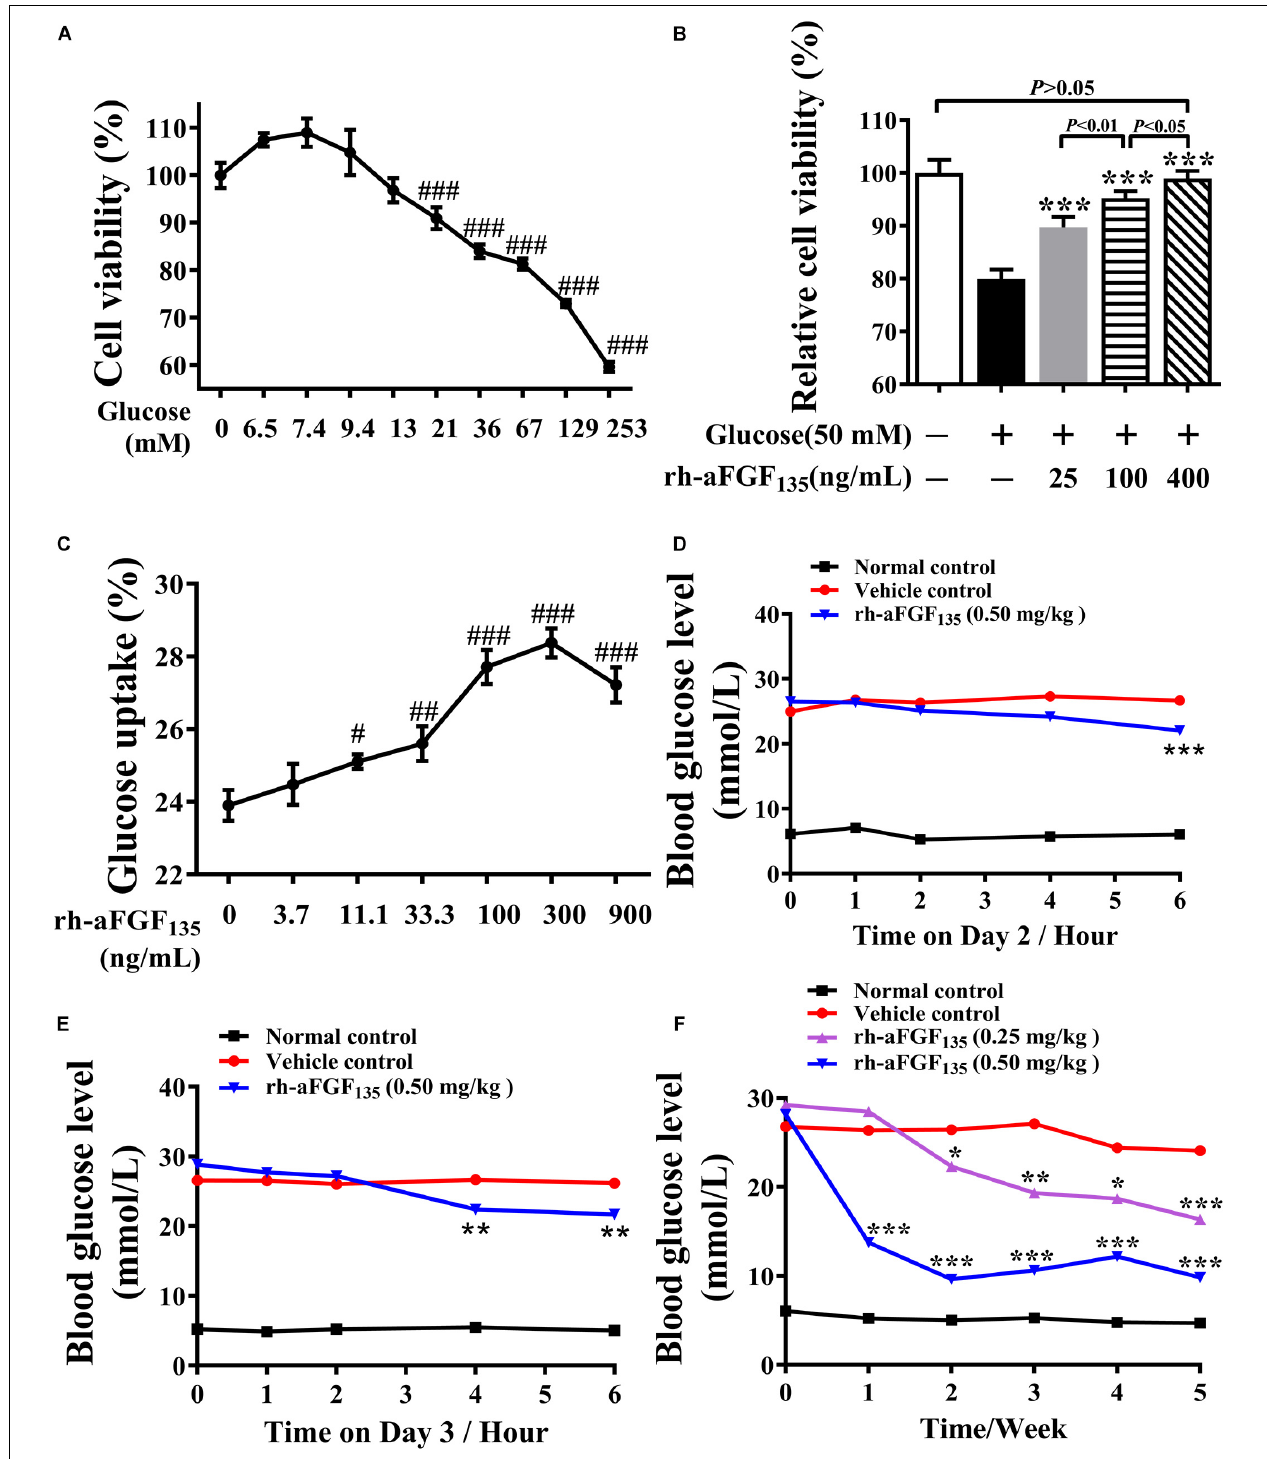
FIGURE 1 | Effects of rh-aFGF 135 on cell viability and glucose uptake activity, and the anti-diabetic effect of rh-aFGF 135 in diabetic ZDF rats. (A) HepG2 cell viability under different concentrations of glucose in glucose-induced damage model. (B) The effect of rh-aFGF 135 on HepG2 cell viability in 50 mM glucose-induced damage model. (C) Glucose uptake rate of HepG2 cells after treatment with different concentrations of rh-aFGF 135 . (D–F) The blood glucose level of ZDF rats on the second day (D) , and the third day (E) and within 5 weeks (F) after rh-aFGF 135 administration. Compared to normal control, ### P < 0.001, ## P < 0.01, # P < 0.05; Compared to vehicle control, *** P < 0.001, ** P < 0.01, * P < 0.05, n = 6.